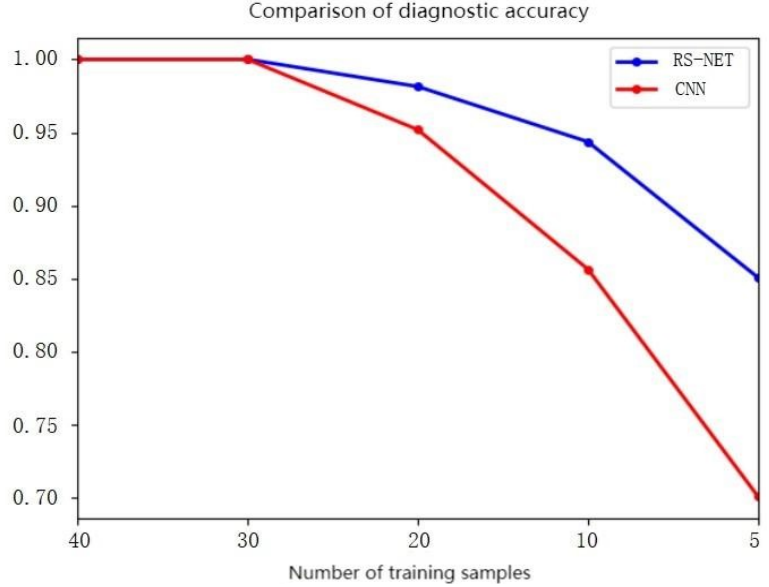
Figure 15. Comparison chart of fault diagnosis accuracy of two methods by number of samples.